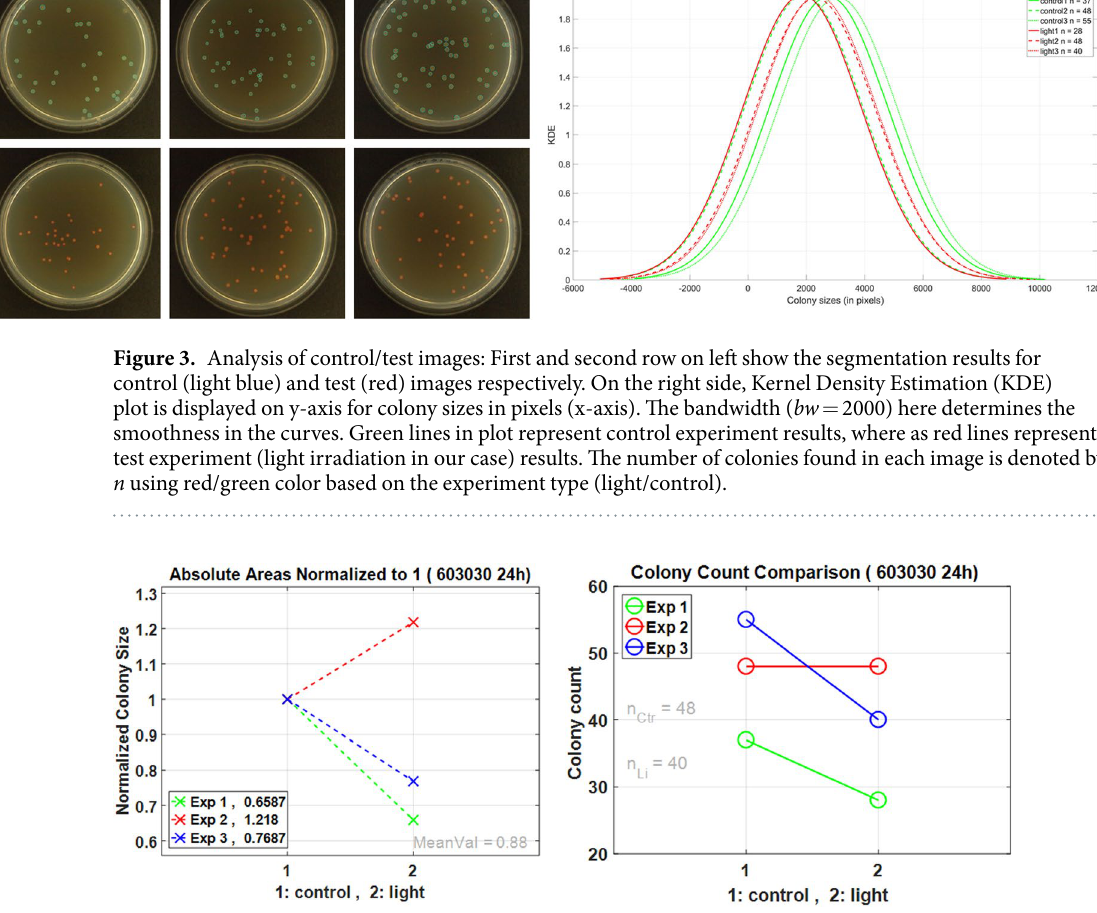
Figure 4. Overview plots of change in total count and size of CFUs after test experiments. The plot on left shows the change in absolute colony sizes (normalized to 1 for each individual control/test pair). This is shown to express the change in size for each pair of experiments. The mean value of the three experiments is given as MeanVal = 0.88. The plot on right is the absolute count of colonies detected in each experiment. n Ctr = 48 and n Li = 40 show average colony count for control and light pictures respectively. The different colors used here are to show different pairs (1:control/2:light) of